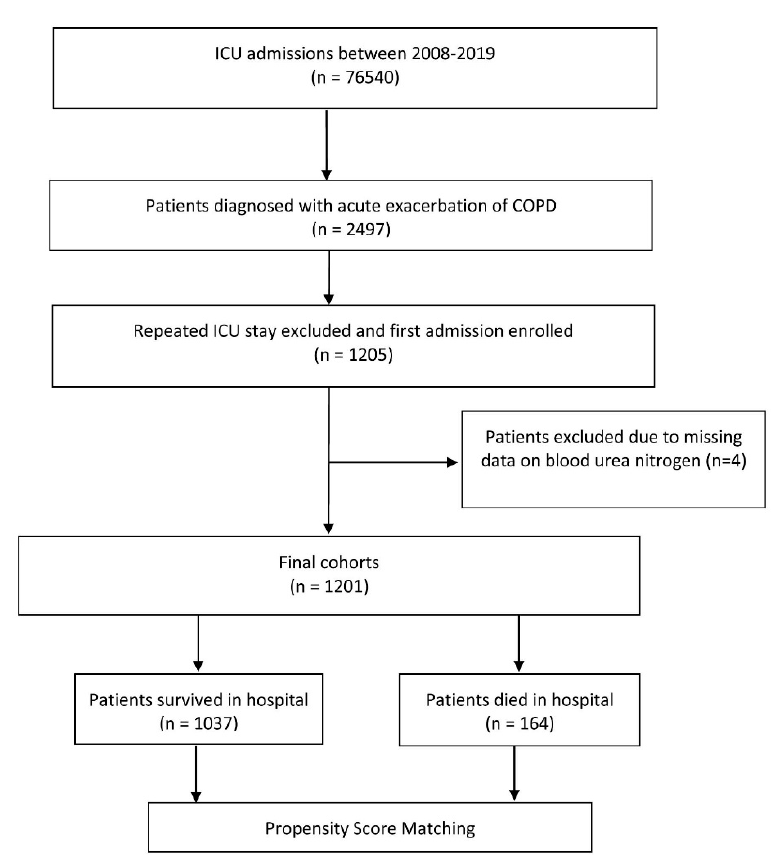
Figure 1. Flow chart of the patient selection process. Table 1. Demographic and clinical characteristics of the study population.